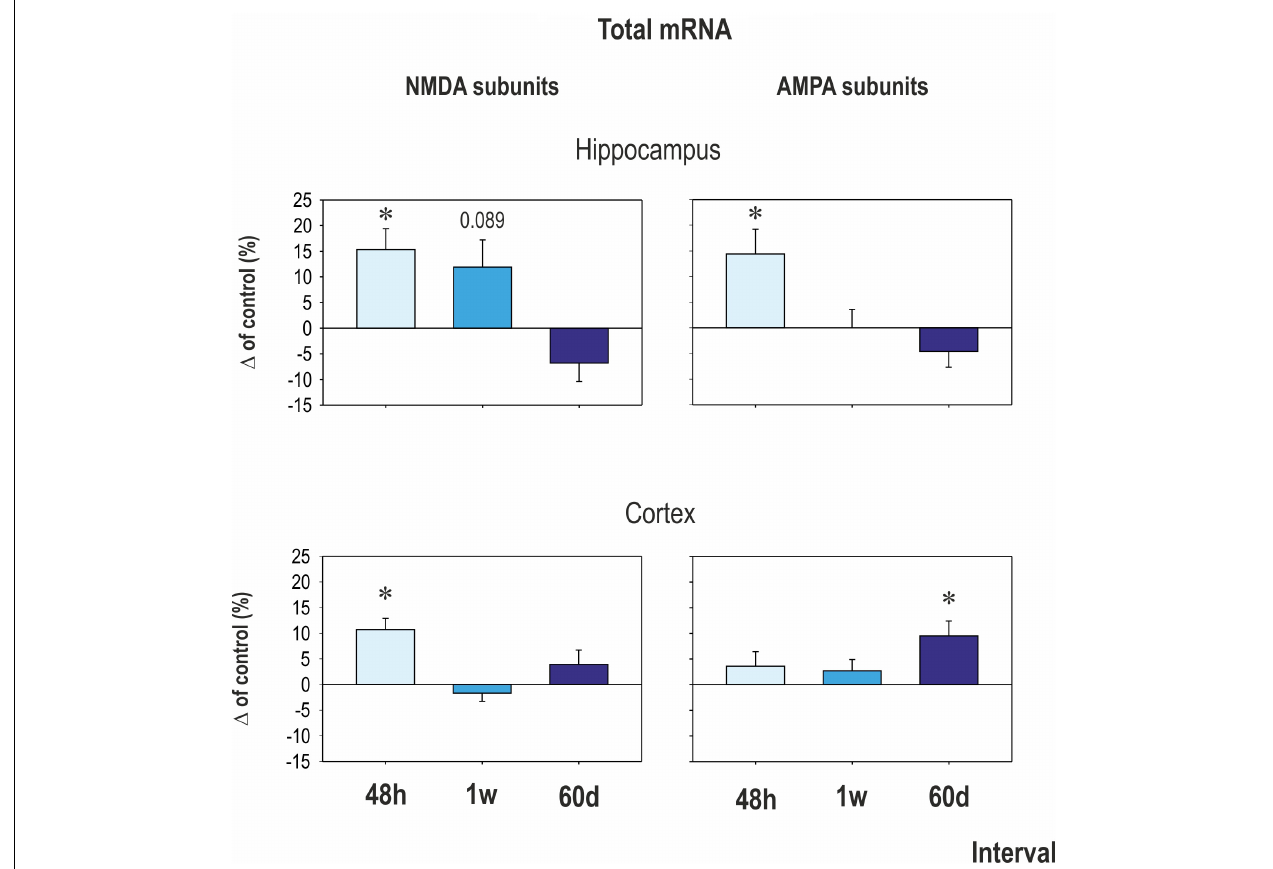
FIGURE 2 | Mean transcriptional levels of evaluated NMDA and AMPA receptor subunits in hippocampus and cortex at three intervals after CZP cessation. mRNA levels were determined using quantitative RT-PCR, and values were converted to a percentage of the control values, which were considered baseline (zero) levels. Mean percent changes in all evaluated subunits are presented ( ± SEM). Asterisks denote significant differences compared to controls.